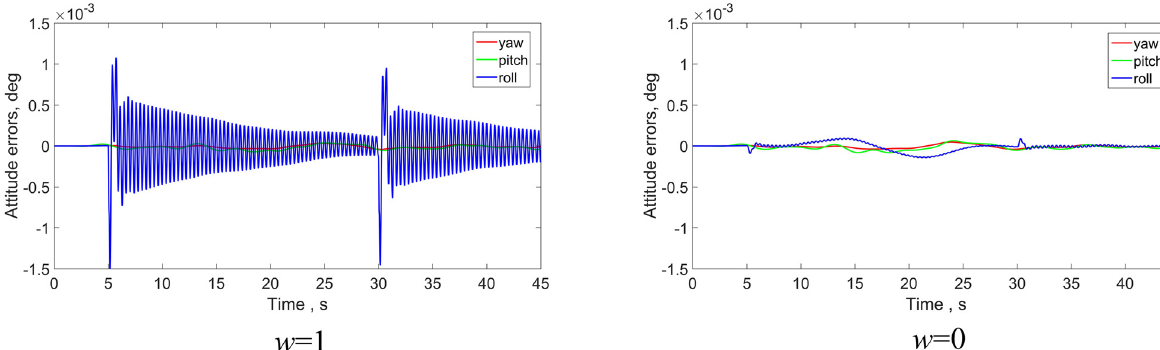
Figure 25: Angle attitude errors for case 3.